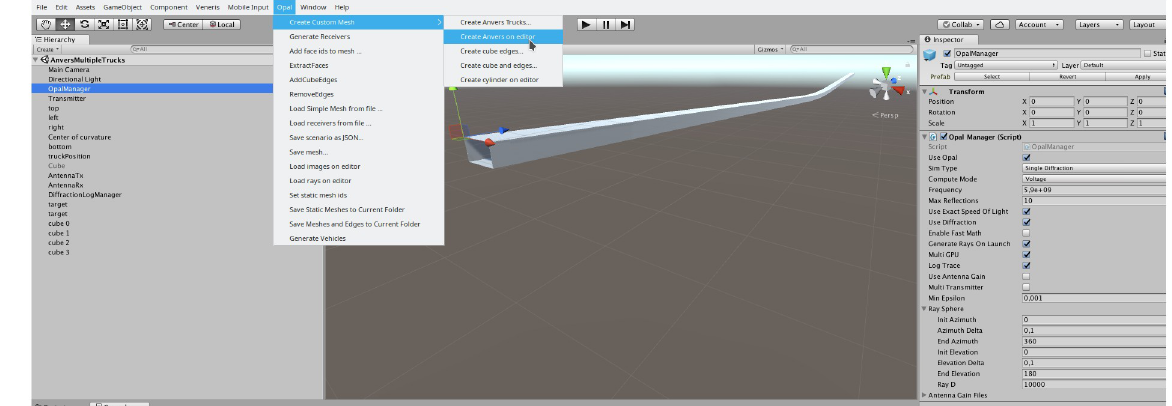
Fig 6. Anvers tunnel scenario. The tunnel has been procedurally generated and the Unity Editor menu has been extended to generate the scenario. Snapshot taken from the Opal tool.